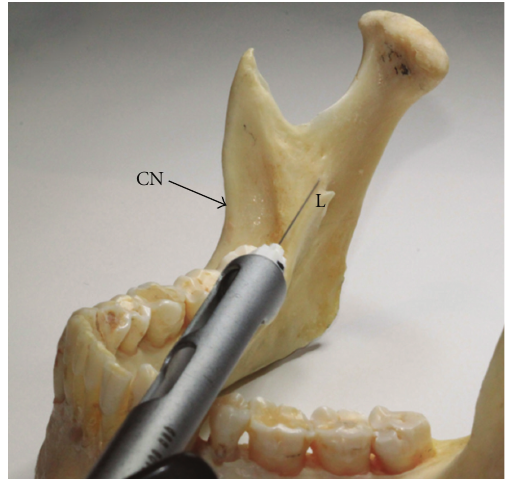
Figure 2: Photograph of the mandible where the needle tip is directed toward the area of bone just superior to the lingula. This positioning of the needle will allow for local anaesthetic deposition in a location in close proximity to the IAN and associated vessels, yet minimising the risk of damaging them. This photograph reflects where local anaesthetic is injected with the direct and indirect IANB (CN: Coronoid notch, L: Lingula).